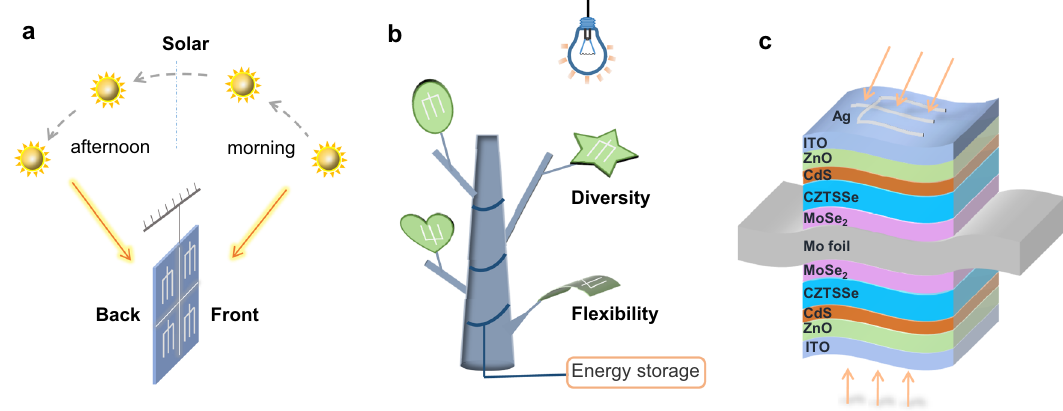
Fig. 1 Applications and structure of bifacial solar cells. a The diagram of overhung bifacial solar cells. b The diagram of indoor photovoltaic application using fl exible bifacial solar cells. c Device structure diagram of bifacial fl exible CZTSSe solar